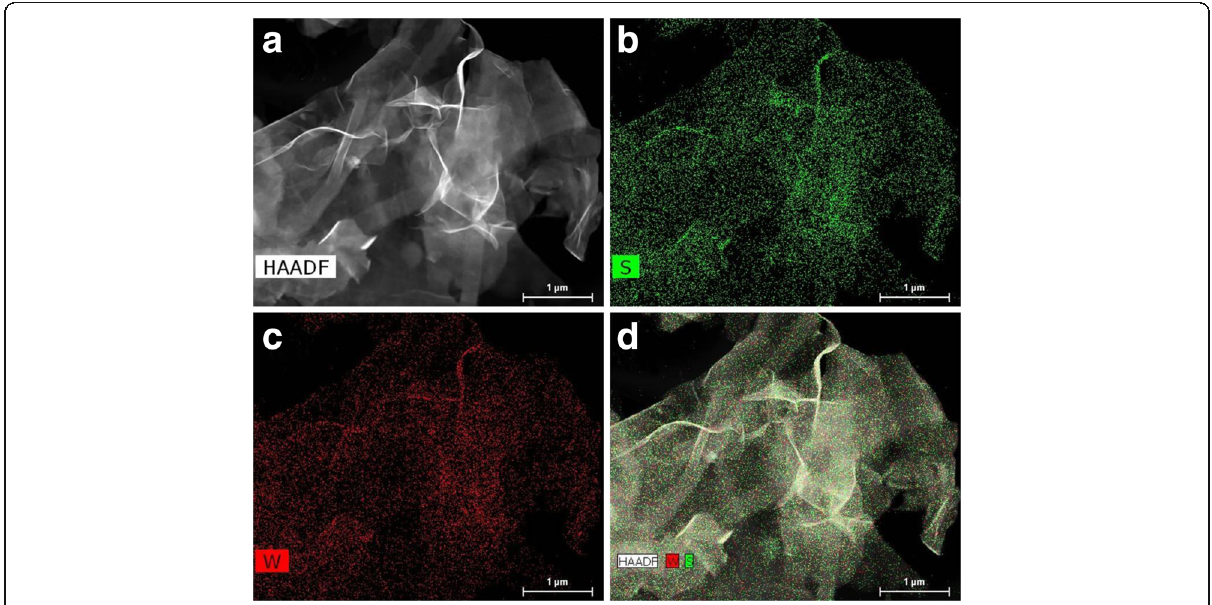
Fig. 2 HAADF-STEM image ( a ) and corresponding elemental mapping ( b for S, c for W, d for S and W) for the 1T-WS 2